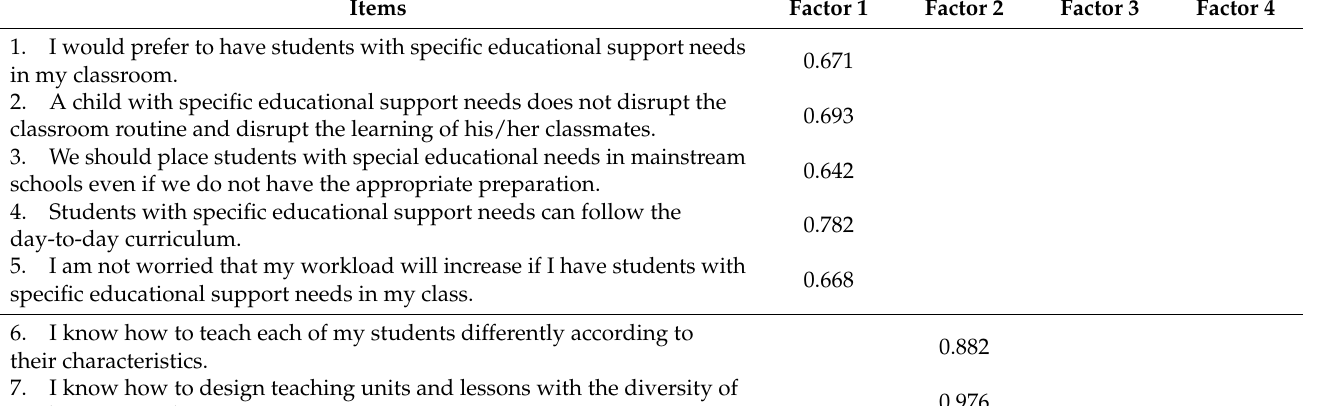
Table 3. CEFI-R questionnaire rotated factor solution and factor